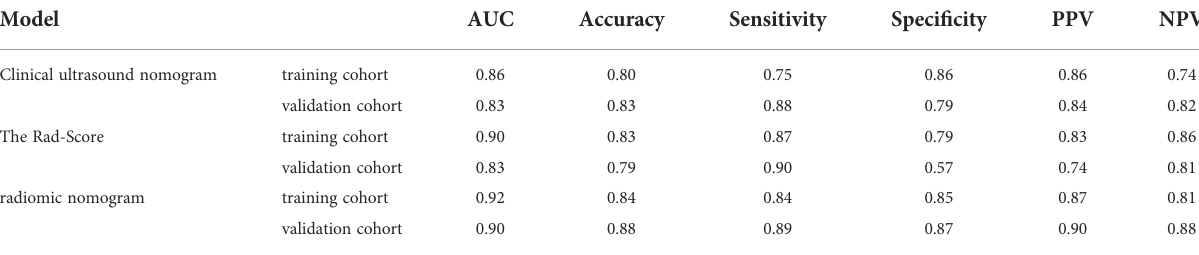
TABLE 5 Predictive performance of the radiomics nomogram compared with clinical ultrasound nomogram and the rad-score. Model